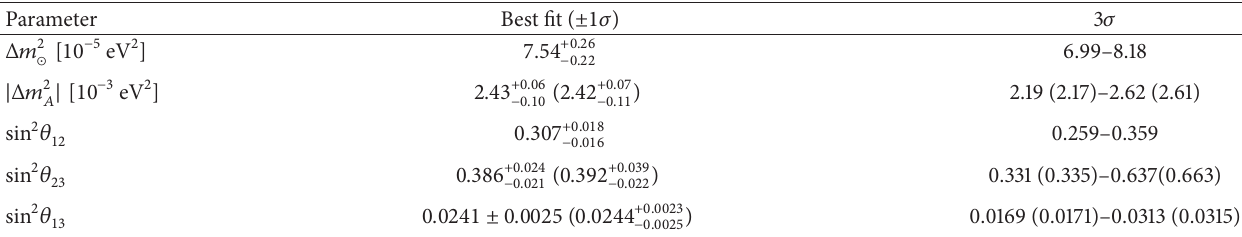
Table 1: The best-fit values and 3𝜎 allowed ranges of the 3-neutrino oscillation parameters, derived in [33] from a global fit of the current neutrino oscillation data. The values (values in brackets) correspond to 𝑚 1 < 𝑚 2 < 𝑚 3 ( 𝑚 3 < 𝑚 1 < 𝑚 2 ). The definition of Δ𝑚 2 𝐴 used is: = 𝑚 2 − (𝑚 2 + 𝑚 2 )/2 Δ𝑚 2 𝐴 3 2 1